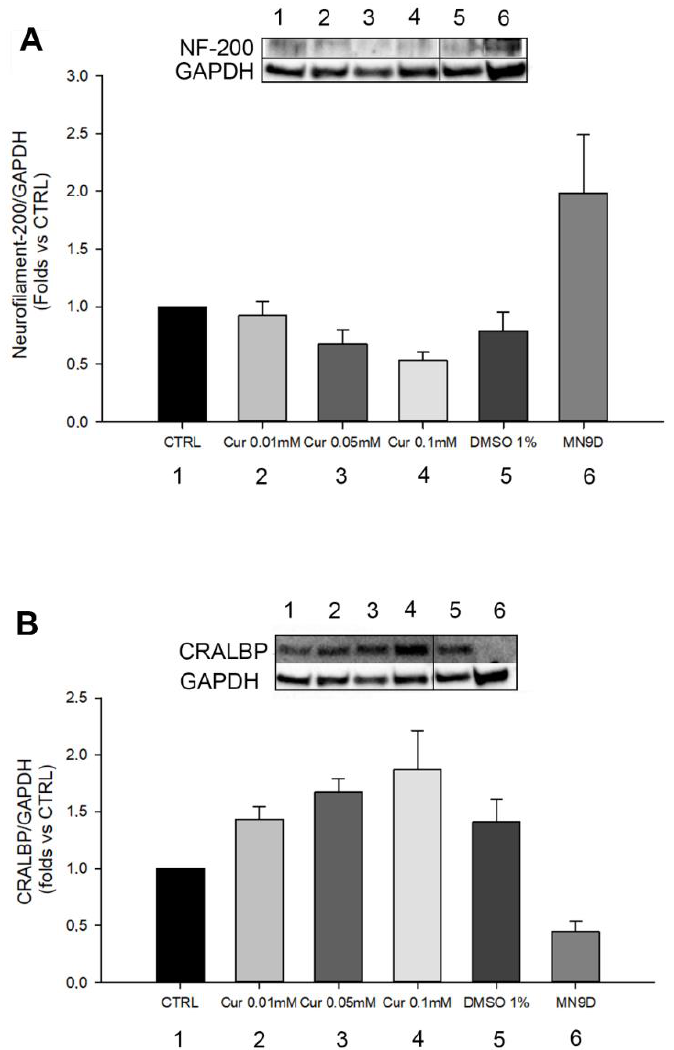
Figure 5. Differentiation analysis by western blot technique ( A , B ). Quantification of Neurofilament- 200 and CRALBP protein levels in each experimental group. Statistical analysis was performed using one-way ANOVA test. No significant differences emerged from the analysis (n = 3). The expression analysis of NF-200 and CRALBP in all the vehicles groups are reported in Figure S5. Original Western Blot bands of NF-200 and CRALBP are showed in Figure S7 and Figure S8, respectively.